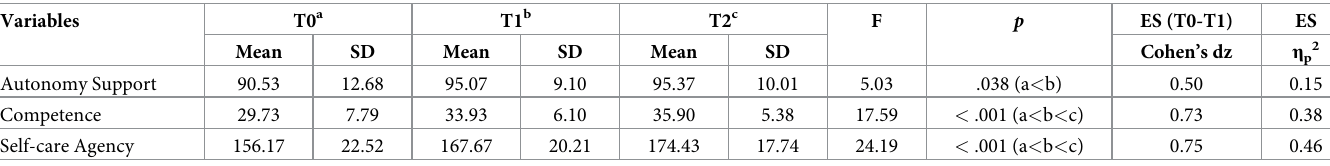
Table 3. Effects of the self-management program on autonomy support, competence, and self-care agency (N = 30).